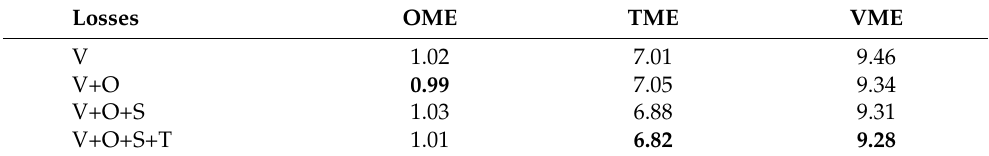
Table 4. Comparison results for adding loss components on Human3.6M. V: Vertex loss, O: Orien- tation loss, S: Smoothness loss, T: Translation loss. The best results are shown in